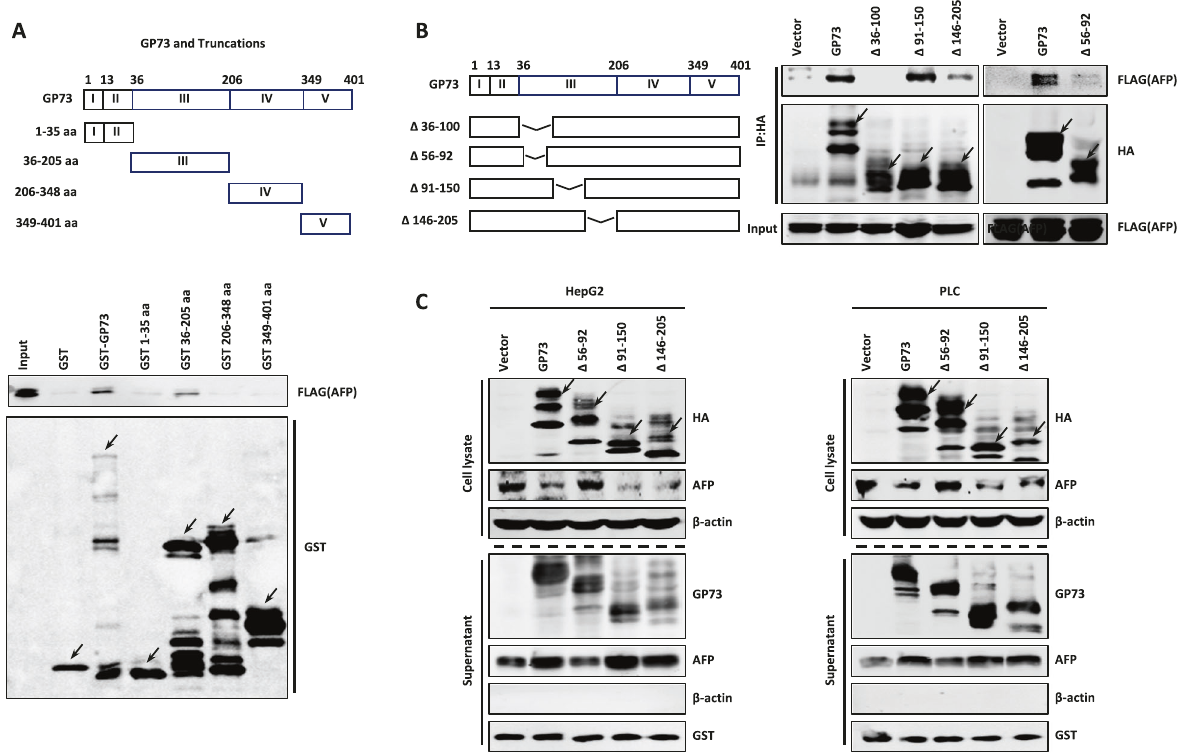
Fig. 3 GP73-mediated AFP secretion depends on the interaction of GP73 with AFP. A AFP interacts with domain III of GP73. GST pull-down assay was performed by using lysate of HEK293T cells transfected with FLAG-AFP and GSTor GST-tagged various domain of GP73 proteins and analyzed by western blotting with anti-FLAG antibody. B AFP interacts with 56 – 92 aa in domain III of GP73. HEK293T cells co-transfected with FLAG-AFP and HA-tagged GP73, Δ 36 – 100, Δ 56 – 92, Δ 91 – 150, or Δ 146 – 205 were lysed with IP lysis buffer and subjected to immunoprecipitation with anti-HA or anti-FLAG antibodies followed by western blotting with anti-HA or anti-FLAG antibodies. C Deletion of 56 – 92 aa in domain III of GP73 reduces AFP secretion. The protein levels of GP73 and AFP in cell lysate and supernatant were measured by western blotting in HepG2 and PLC cells transfected with vector, GP73, Δ 56 – 92, Δ 91 – 150, or Δ 146 – 205 plasmid. β -actin or GST was respectively used as an intracellular or extracellular